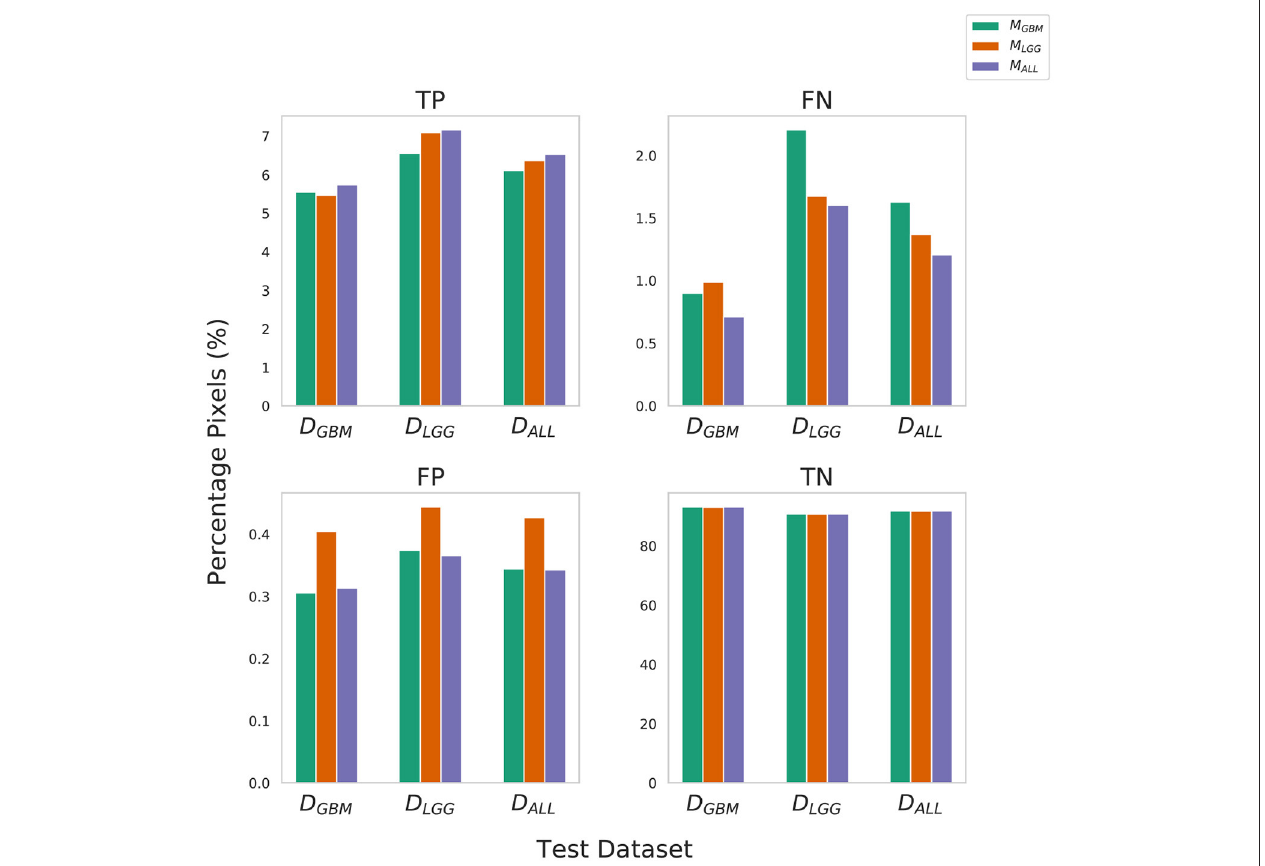
FIGURE 2 | Confusion Matrix to assess the performance of M GBM , M LGG , and M ALL across stratified and composite datasets. The y-axis denotes percentage of total pixels in a test dataset classified as TP, FN, FP, TN. M LGG has the tendency to over-segment (high %FP), while M GBM has the tendency to under-segment tumor(high %FN), relative to each other. Note that metrics such as Dice coefficient routinely ignore the background (TN) in a segmentation context, so a 0.1% difference in false positives should be understood relative to the 6–9% of the volume that is